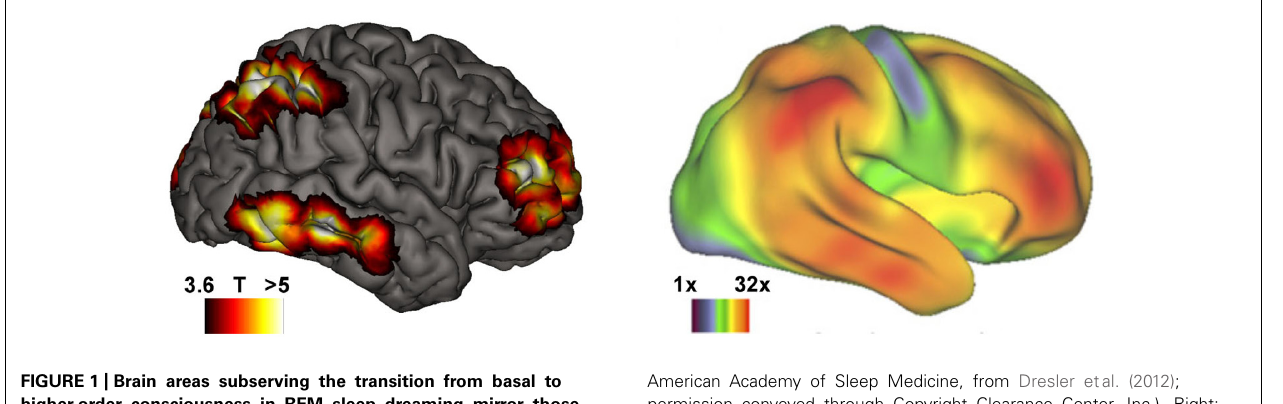
FIGURE 1 | Brain areas subserving the transition from basal to higher-order consciousness in REM sleep dreaming mirror those with strongest volumetric expansion in humans compared to non-human primates. Left: during lucid dreaming, the dorsolateral prefrontal and frontopolar cortices, parietal lobules, and inferior/middle temporal gyri among other cortical regions are strongly activated as compared with non-lucid REM sleep (republished with permission of the